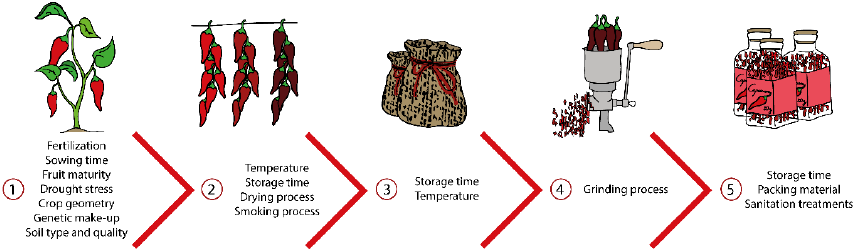
Figure 2. Extrinsic and intrinsic factors that can affect capsaicinoids and capsinoids biosynthesis and degradation throughout the Capsicum production chain.